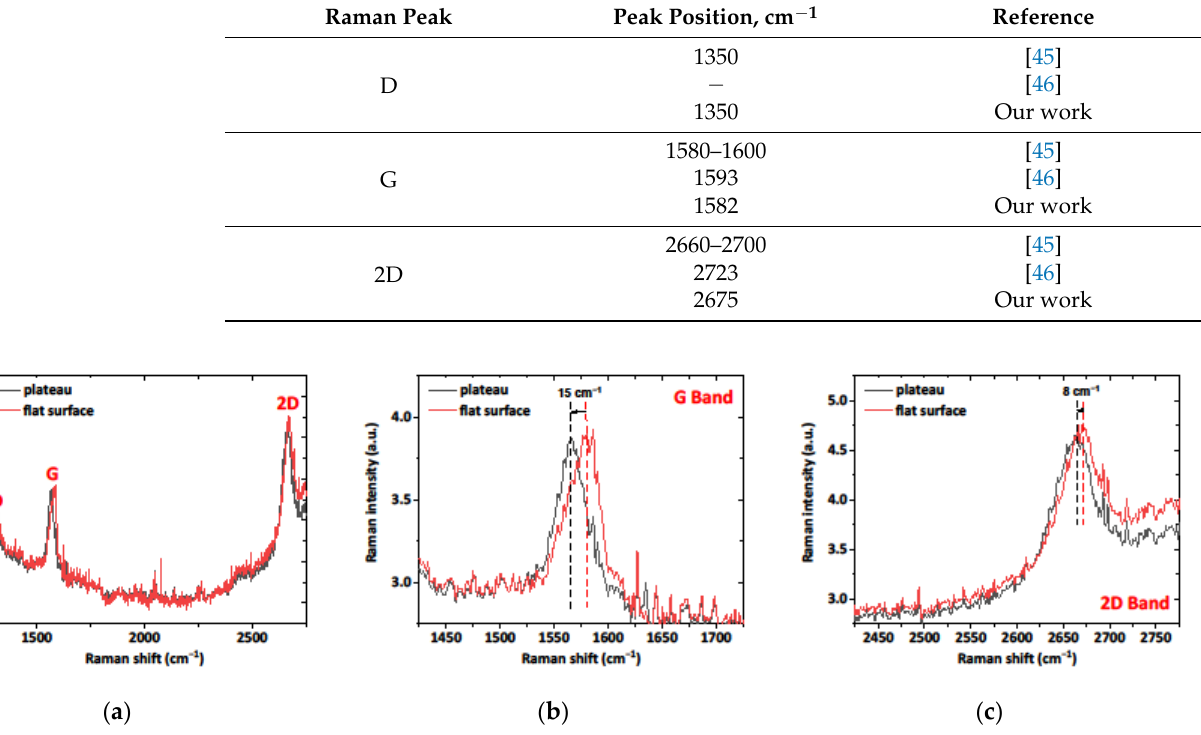
Figure 5. Raman spectra of few − layer graphene on the quartz substrate ( a ), focusing on the G − band ( b ) and 2D − band ( c ) regions, respectively. ( b ) and 2D − band ( c ) regions,